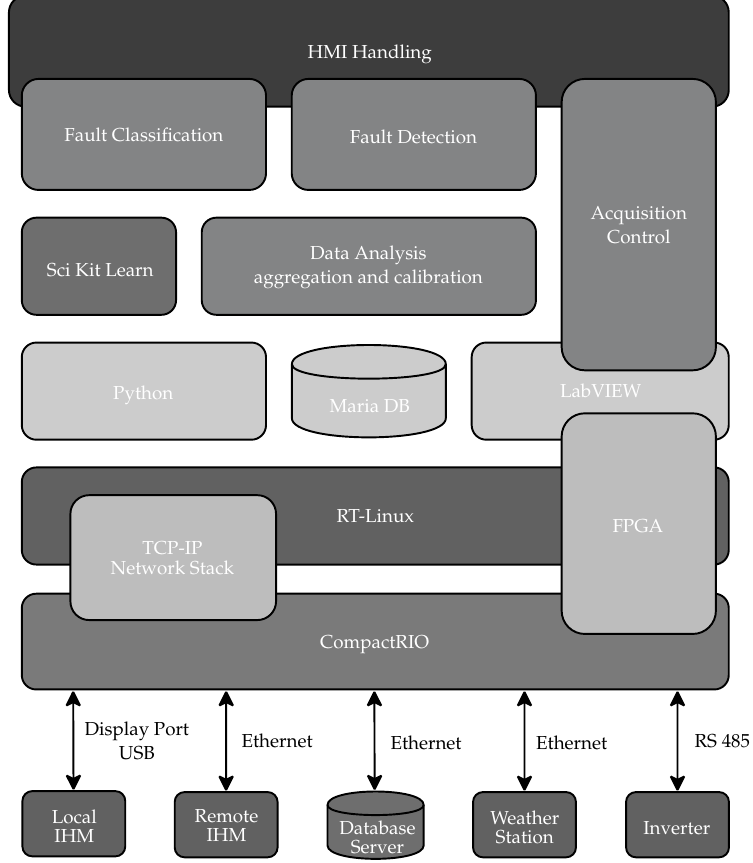
Figure 5: The proposed method consists in transmitting a frame using ⌈ α n cha ⌉ channel uses for the fi rst trans- Figure 5. Software stack of the monitoring system, including the applications at the toplevel and mission attempt, with 0 < α ≤ 1 . In the event of a decoding error, incremental redundancy is transmitted hardware and interfaces at the bottom 1 − α n cha ⌋ channel uses. making use of the rest of the available ⌊ ( )